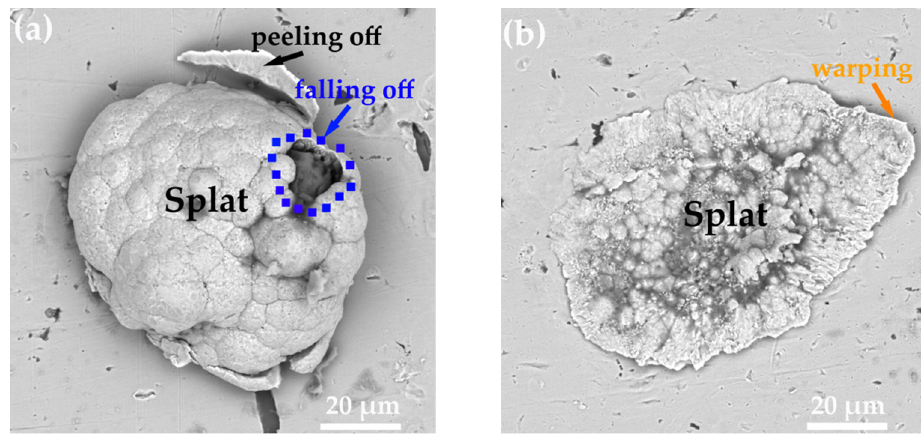
Figure 5. Surface morphologies of Ni-coated Al splat deposited onto a Q235 steel substrate at an accelerating gas temperature of ( a ) 200 °C and ( b ) 400 °C.